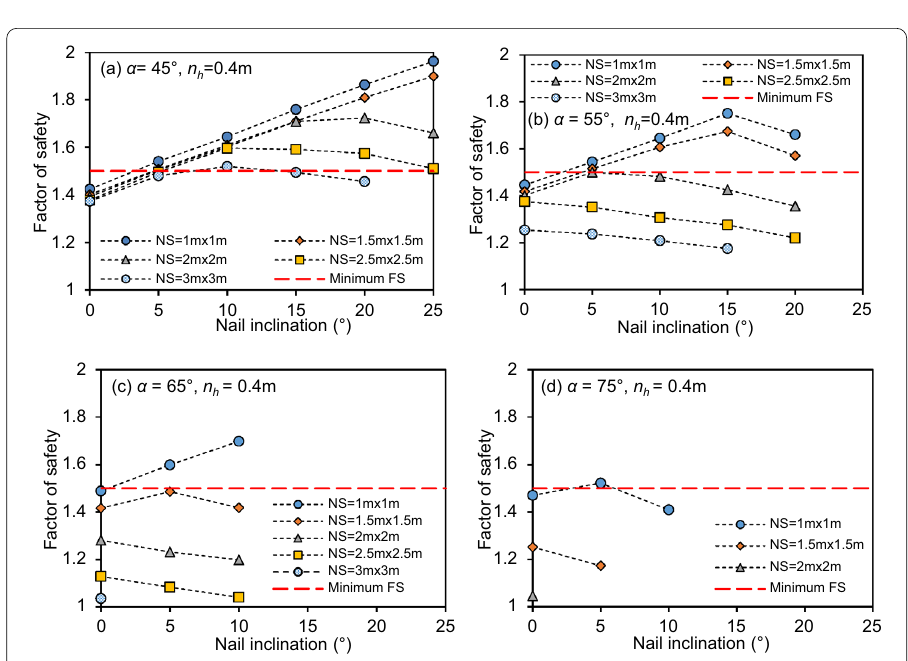
Fig. 6 The effect of nail head size equal to 0.4 m in four different slope